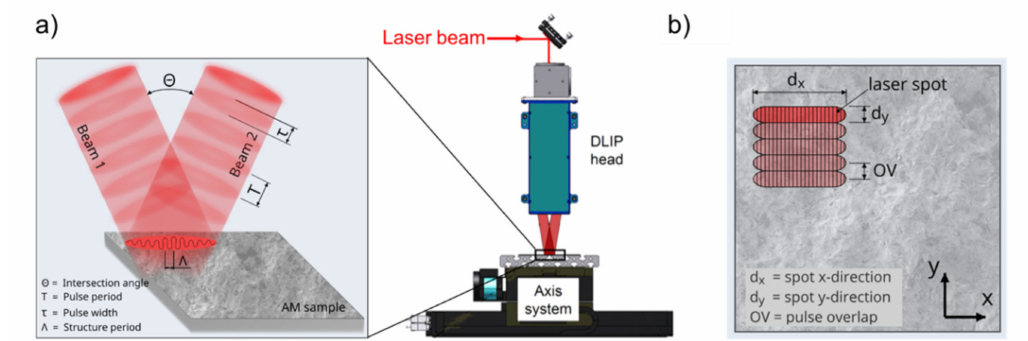
Figure 1. ( a ) Experimental setup (TU Dresden, Fraunhofer IWS) developed for processing large area surfaces with an illustration of two elongated laser beams overlapping on the substrate surface (left side); ( b ) Schematic drawing of the moving process strategy for the DLIP process with the most relevant